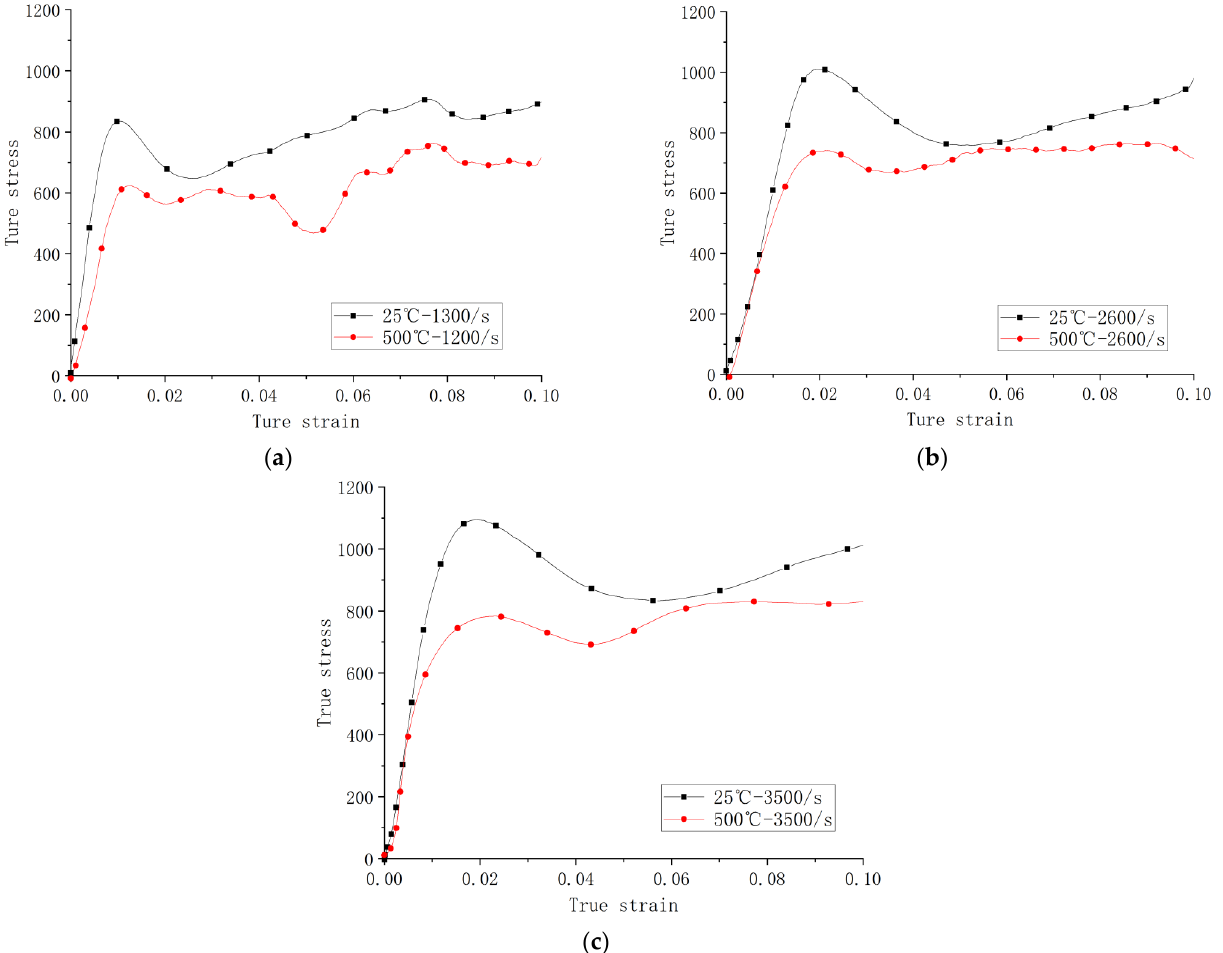
Figure 12. Stress–strain curves of dynamic compressive tests ( a ) at ambient temperature under 1300 s − 1 and at 500 °C under 1200 s − 1 , ( b ) at ambient temperature and 500 °C under 2600 s − 1 , and ( c ) at ambient temperature and 500 °C under 3500 s − 1 .